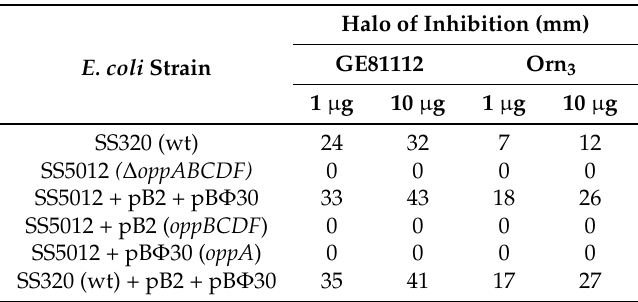
Table 3. Growth inhibition of E. coli strains by GE81112 and tri- L